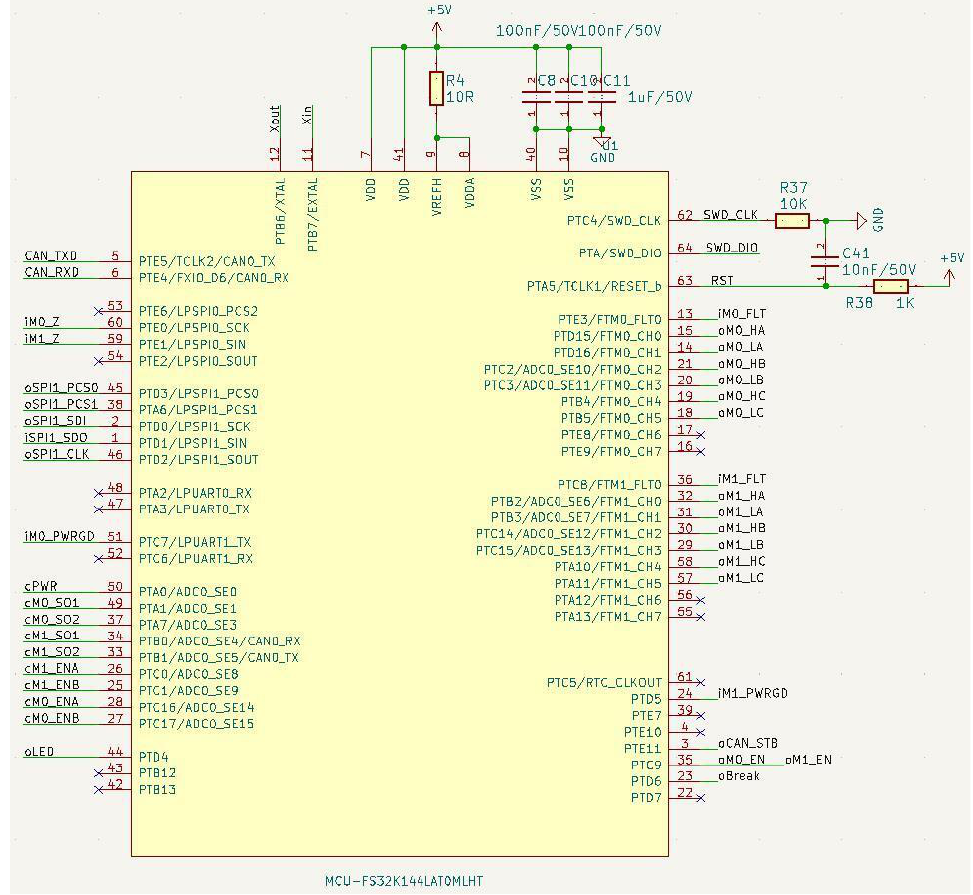
Figure 6. Schematic diagram of the MCU control system circuit.